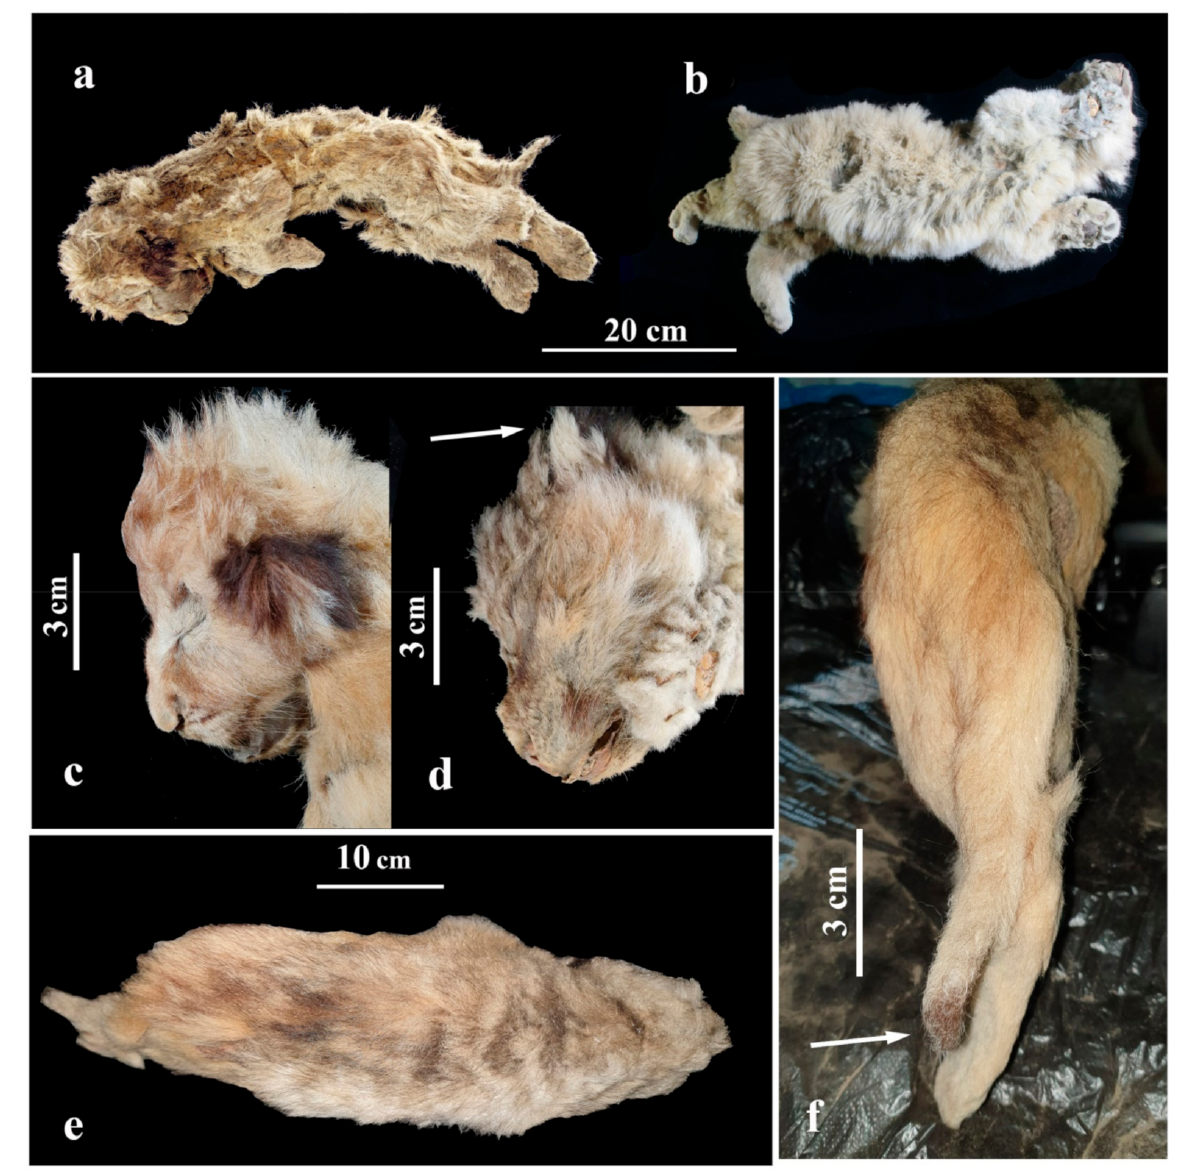
Figure 6. Appearance of the frozen mummies of fossil cave lion cubs: ( a ) female Sparta; ( b ) male Boris. Photos of lion cubs’ heads from the side: ( c ) Sparta; ( d ) Boris; ( e ) Sparta mummy as seen from above; ( f ) dark brown ‘brush’ of Sparta’s